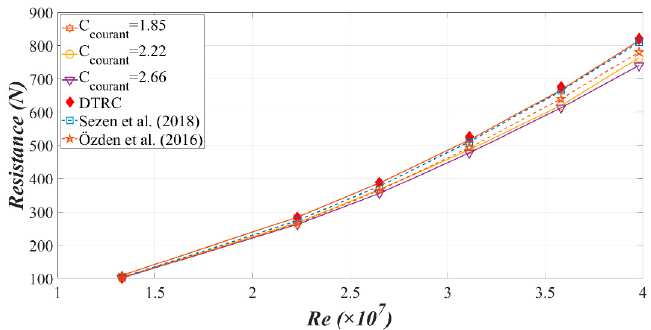
Figure 6. Comparisons of simulation results ( C courant = 1.85, 2.22, 2.66) of the resistance with David Taylor Research Centre (DTRC) experimental data and the published numerical results of [17,49] under different Reynolds numbers.